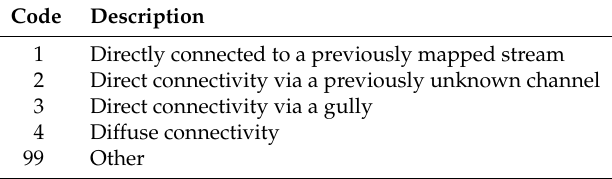
Table A3. Explanatory details for mapping units connected in a natural